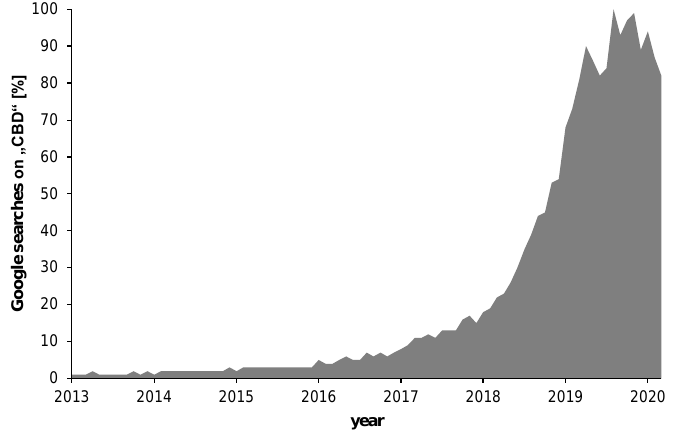
Figure 2. Google trends analysis for cannabidiol (CBD) (Data source: Google Trends [23]).